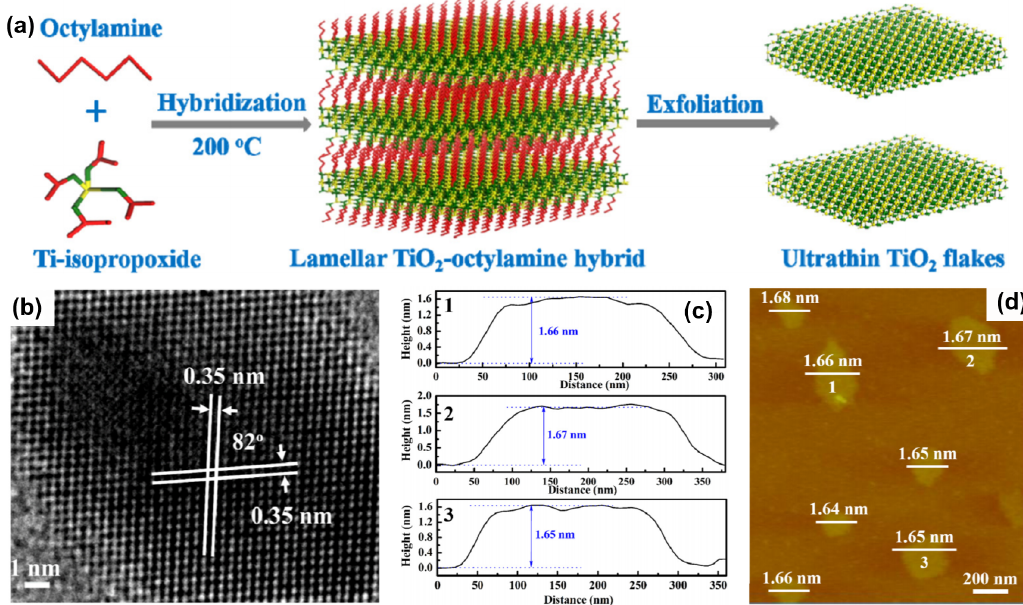
Figure 5. ( a ) Schematic drawing to form ultrathin TiO 2 nanosheets. ( b ) HRTEM image. ( c ) The height profiles corresponding to the AFM image in ( d ); the number from 1 to 3 in ( c ) corresponding to the numbers from 1 to 3 in ( d ). ( d ) AFM image of ultrathin TiO 2 flakes. Reproduced with permission from reference [98]. Copyright 1979,